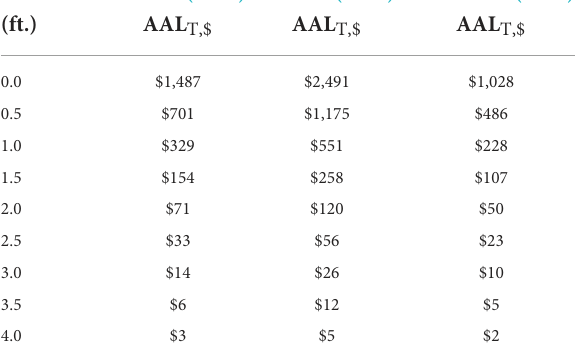
TABLE 5 As in Table 4, but for damage initiation point of − 1 ft relative to FFH. Freeboard USACE (2000) USACE (2006) Nofal et al. (2020)